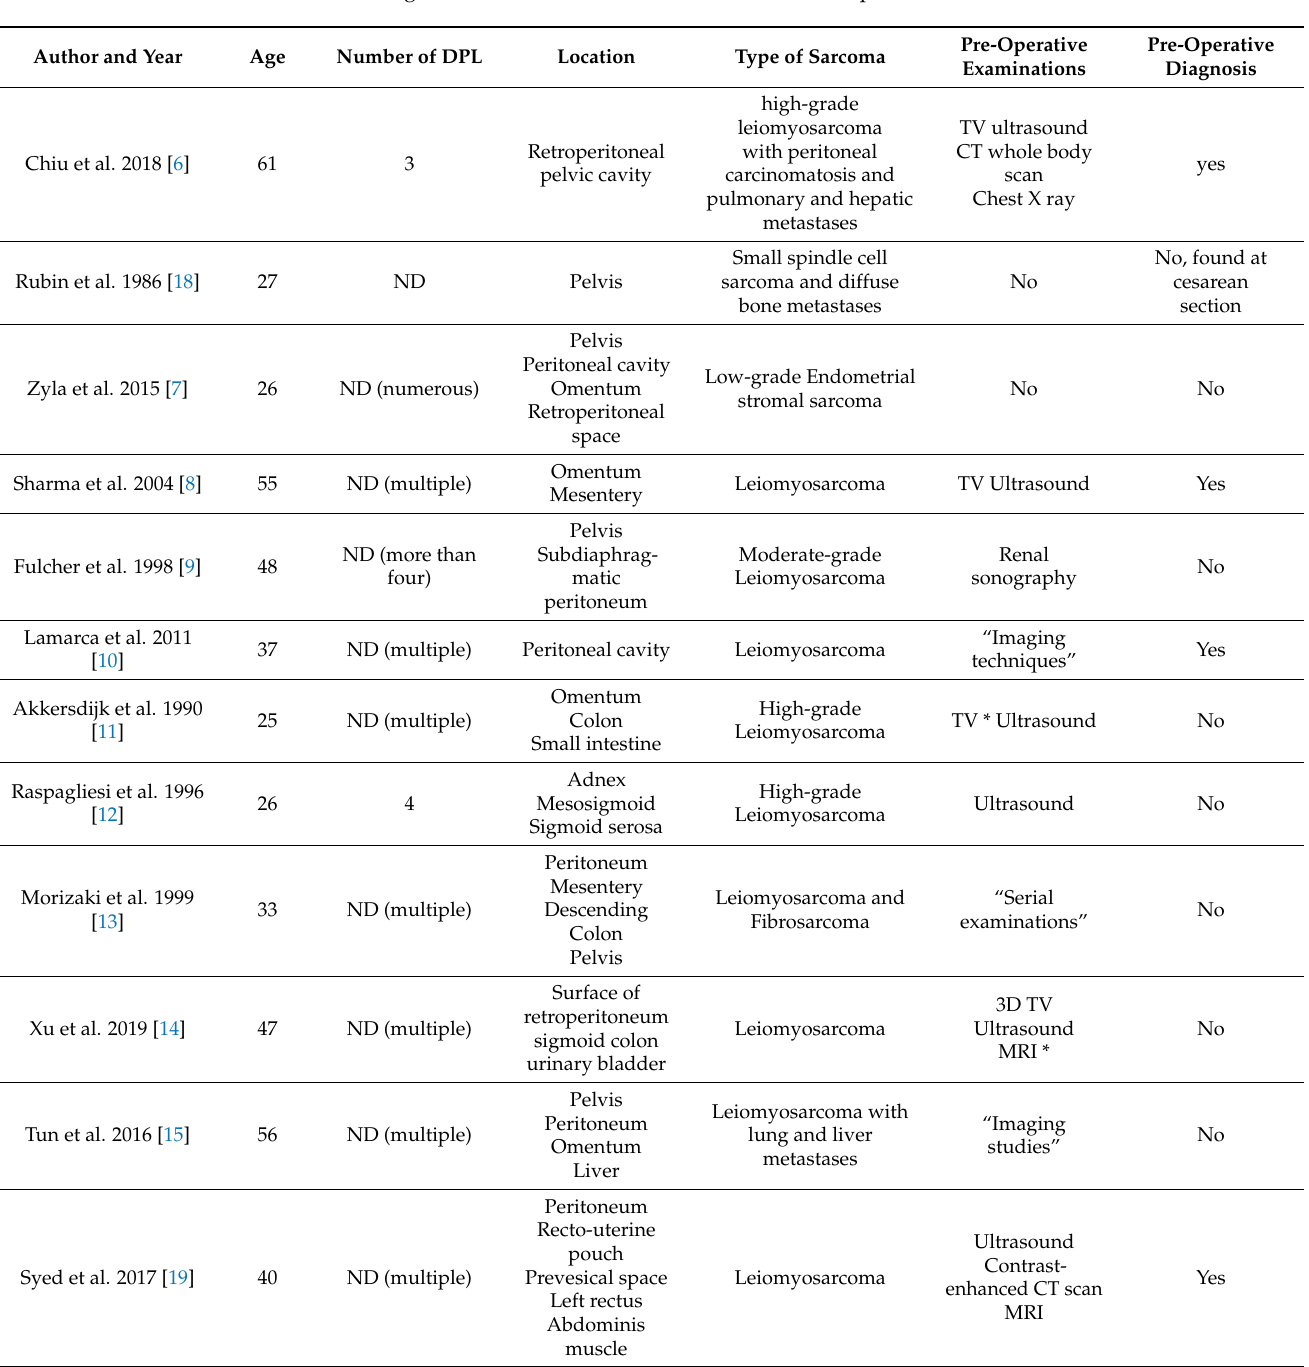
Table 1. Cases of disseminated peritoneal leiomyomatosis with malignant transformation. Abbre- viations: CT: computed tomography, MRI: magnetic resonance imaging, ND: not determined, TV: trans-vaginal, * case described in the current